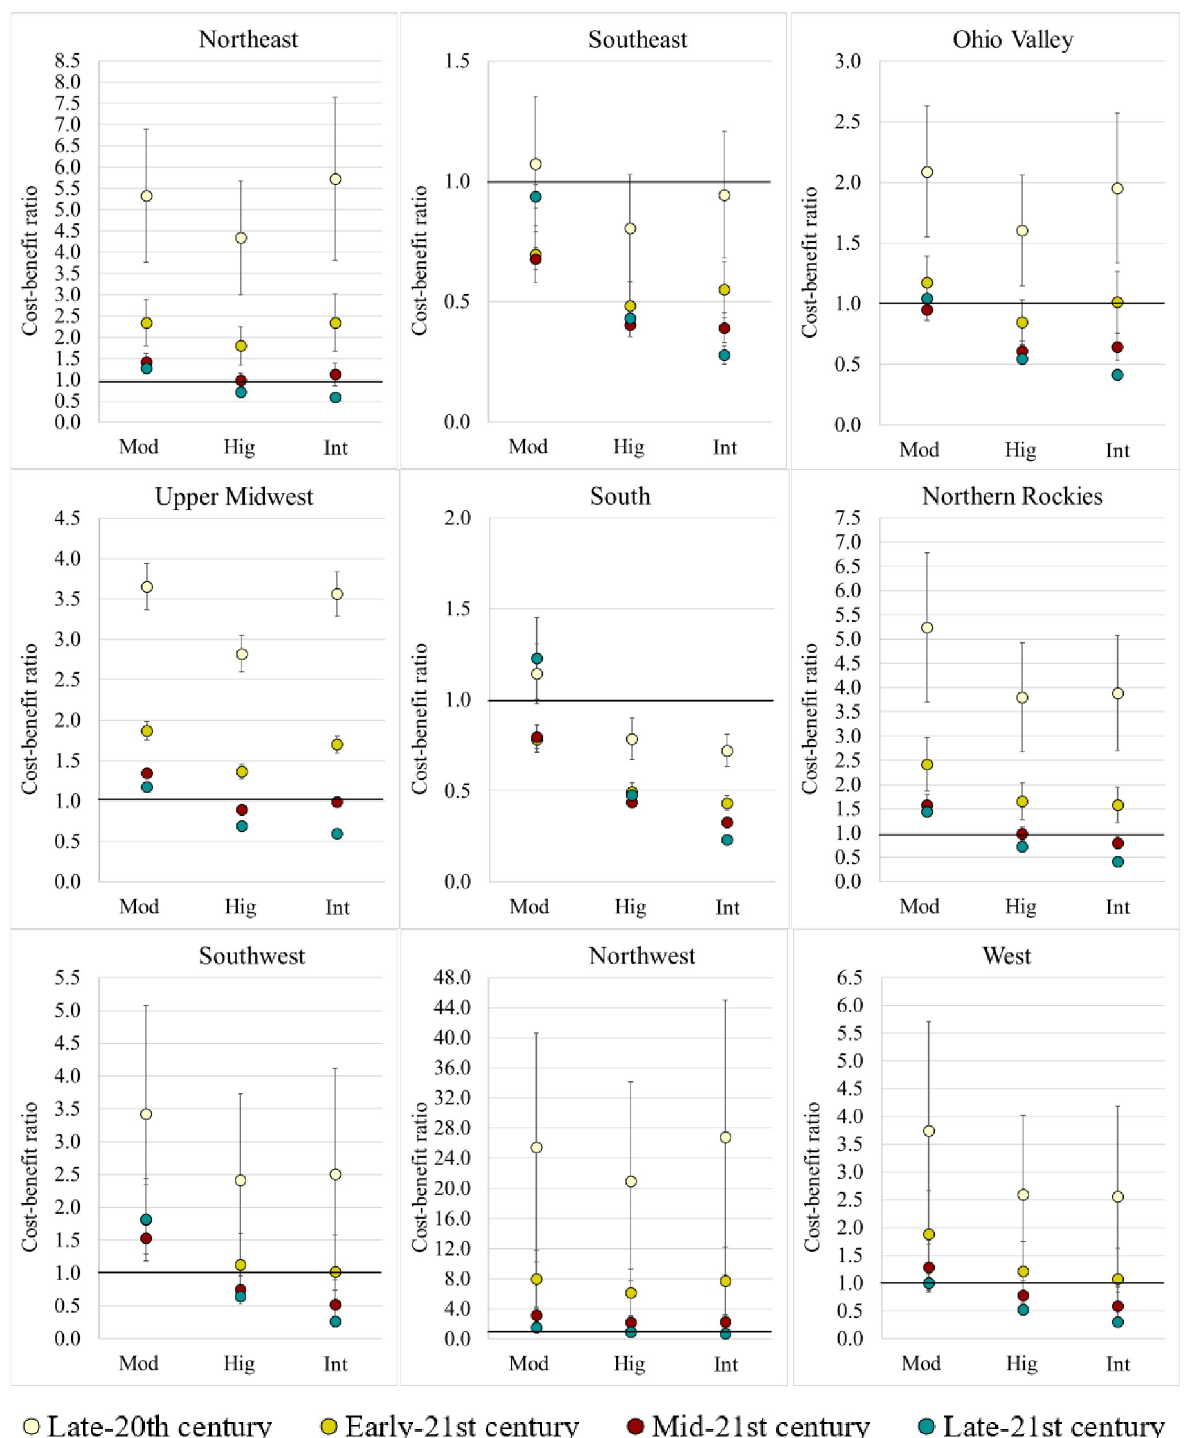
Fig 6. Mean cost-benefit ratios (with error bars) associated with heat abatements by region and period (Mod: Moderate; Hig: High; Int: Intense).